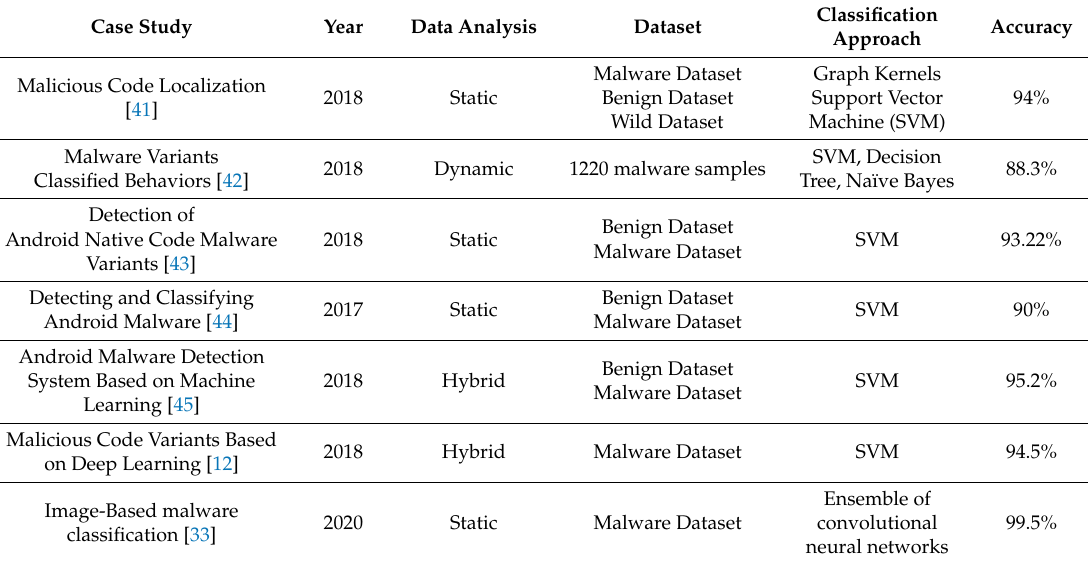
Table 1. Summary of some recent malware detection approaches.